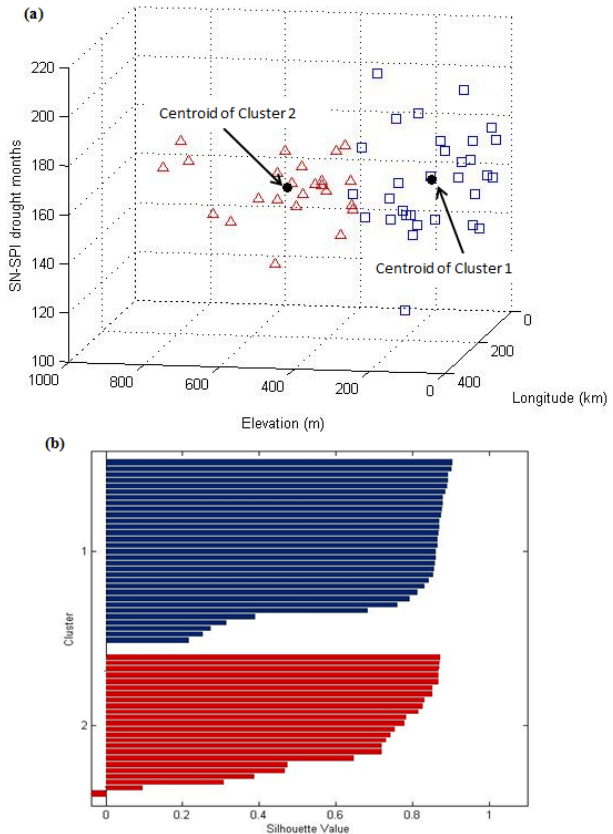
Fig. 6. (a) Monthly precipitation time series for drought events (b) 48-month time scale SN-SPI and (c) SPI for two representative stations of eastern Crete based on the period 1974–2005.